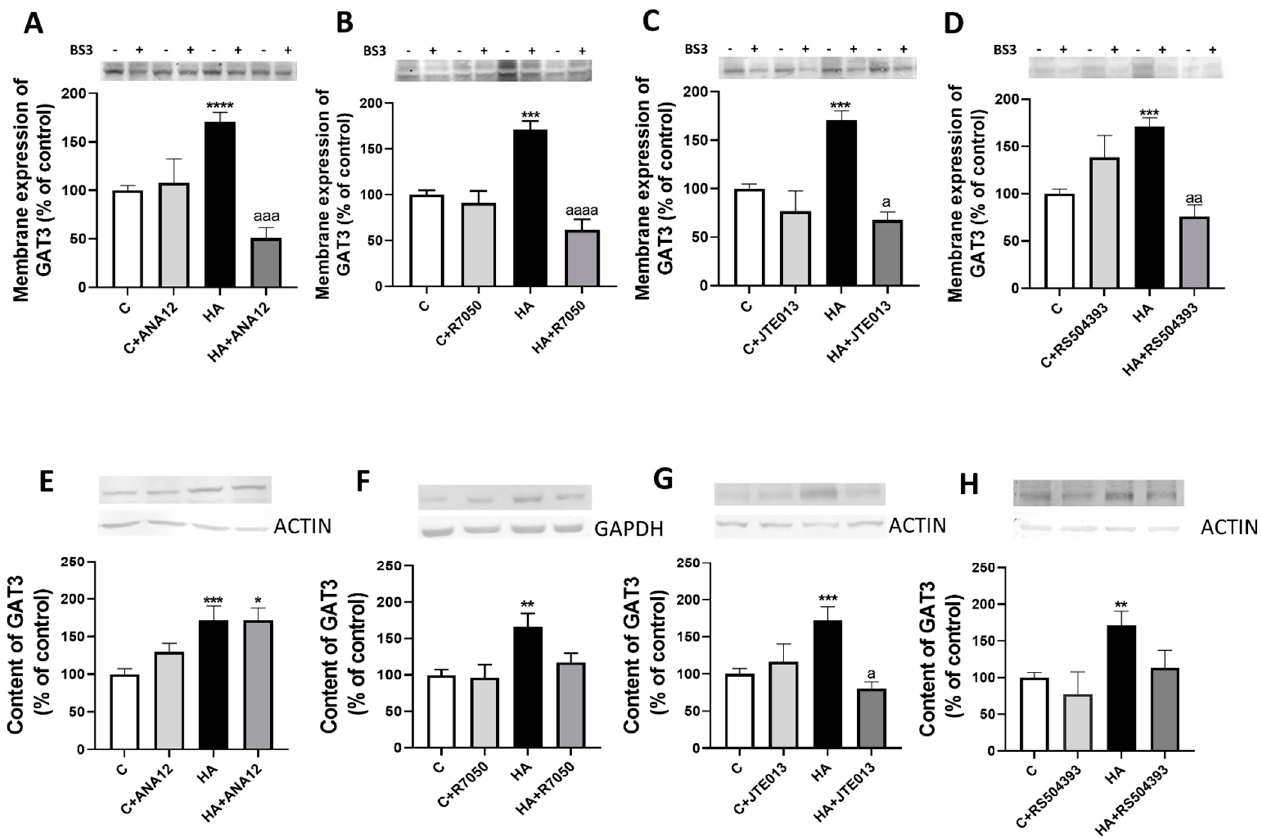
Figure 5. Hyperammonemia increases the membrane expression and total content of GAT3. Ex vivo treatment with ANA12, R7050, JTE-013 or RS504393 reverses most of these increases. ( A – D ) Membrane expression of GAT3 was analyzed using the BS3 cross-linker procedure in slices from control (C) and hyperammonemic (HA) rats. The effects of blocking TrkB with TrkB with ANA12, TNFR1 with R7050, S1PR2 with JTE-013, and CCR2 with RS504393 on the membrane expression of GAT3 are also shown. ( E – H ) Total GAT3 content was analyzed with Western blot in slices from control and hyperammonemic rats treated or not with ANA12, R7050, JTE-013, and RS504393. Actin or GAPDH was used as the loading control. Values are the mean ± SEM of ( A – D ) 23–32 rats and ( E – H ) 17–25 rats per group. Values significantly different from control rats are indicated with asterisks, and from hyperammonemic rats are indicated with “a”. * p < 0.05, ** p < 0.01, *** p < 0.001, **** p <